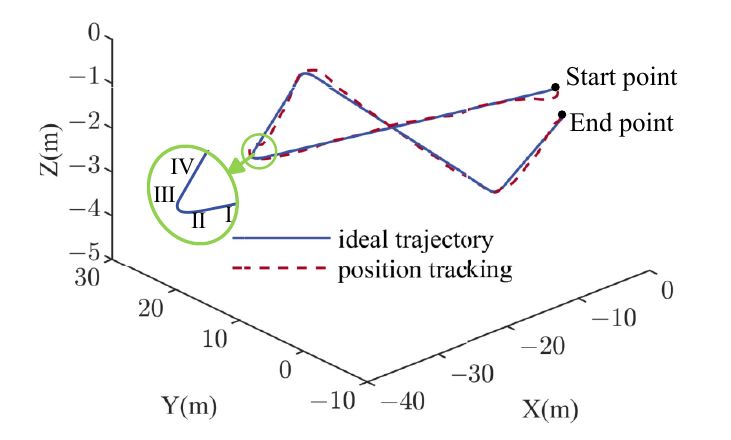
Figure 15. Three-dimensional trajectories of the